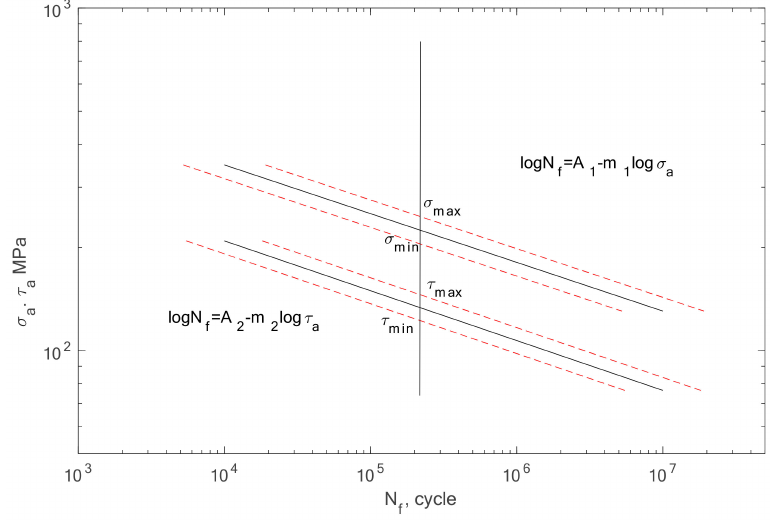
Figure 7. Methodology of presented assumptions—condition